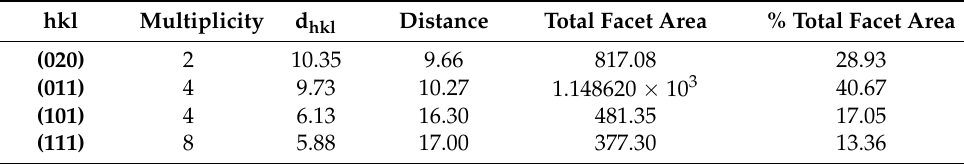
Table 1. Calculated results of the (C 2 H 7 N 4 O) 2 BiCl 5 crystal based on the BFDH law. hkl